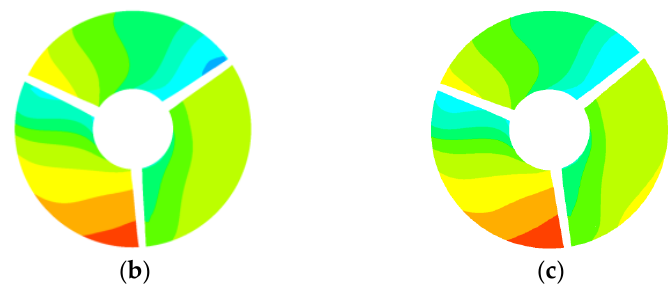
Figure 6. Pressure distribution on the middle section of the runner: ( a ) Operation condition 1; ( b ) operation condition 2; ( c ) operation condition 3.